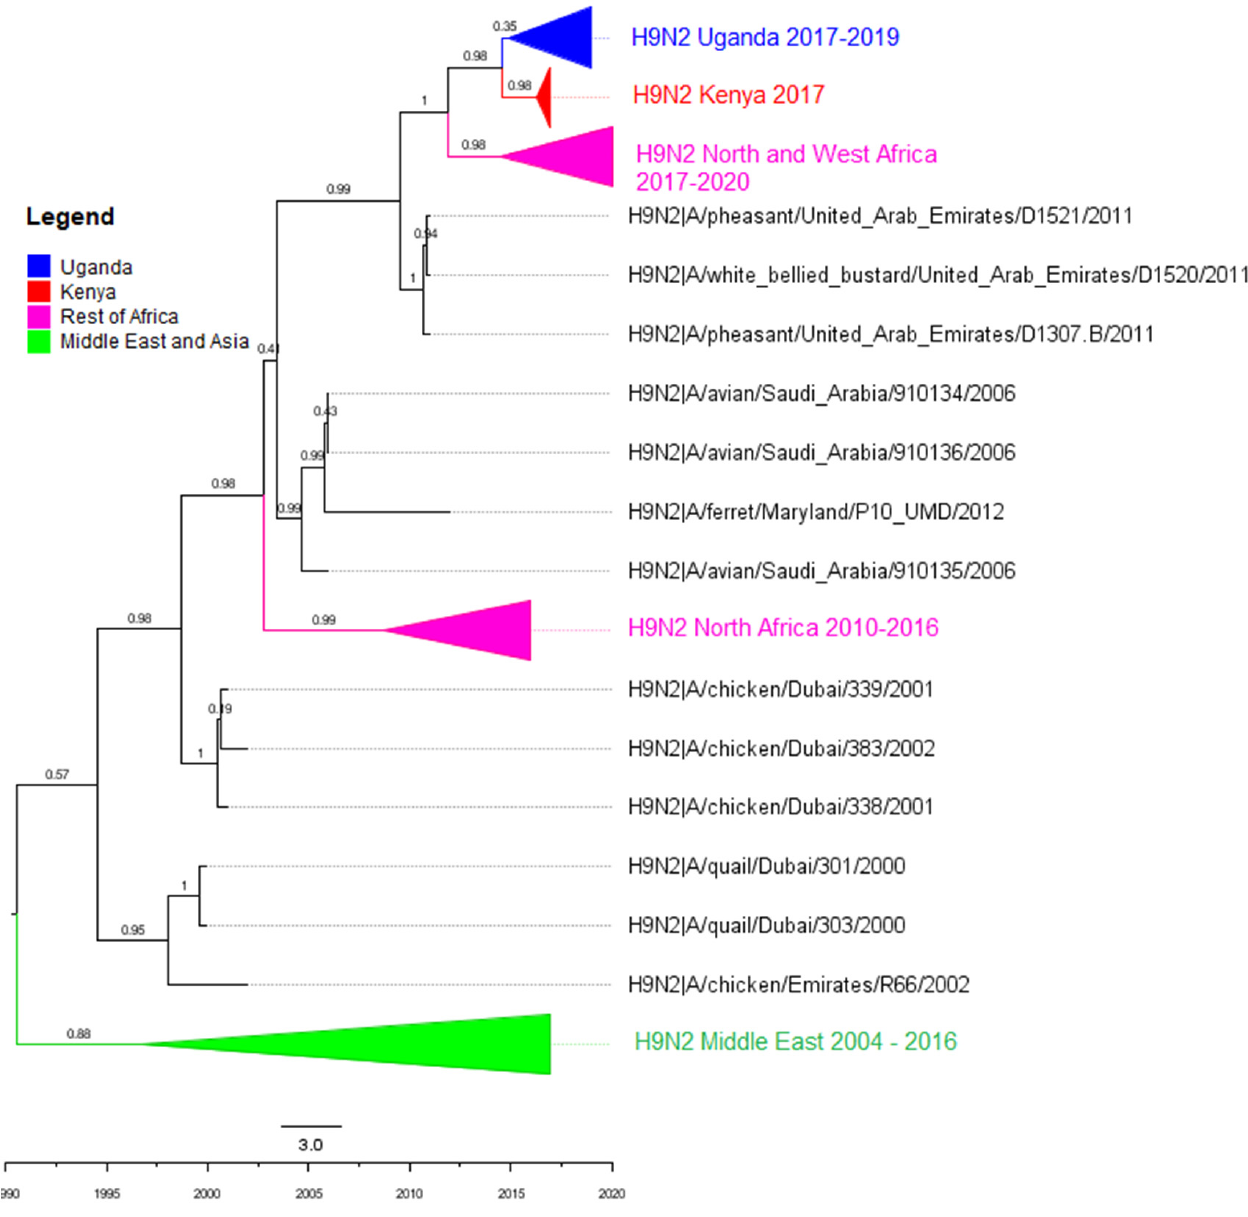
Figure A1. Phylogenetic tree for PB2. Ugandan viruses are highlighted in blue, Kenyan in red, North and West African countries in pink, and the Middle East in the green clade. Posterior probabilities are shown on the branches. tMRCA for Uganda is November 2014. Scales represent substitutions and